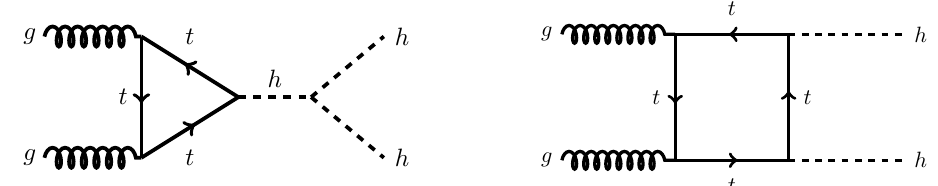
Figure 1. Lowest order Feynman diagrams contributing to di-Higgs production via gluon-gluon fusion. An additional box diagram with crossed (cid:12)nal states is not